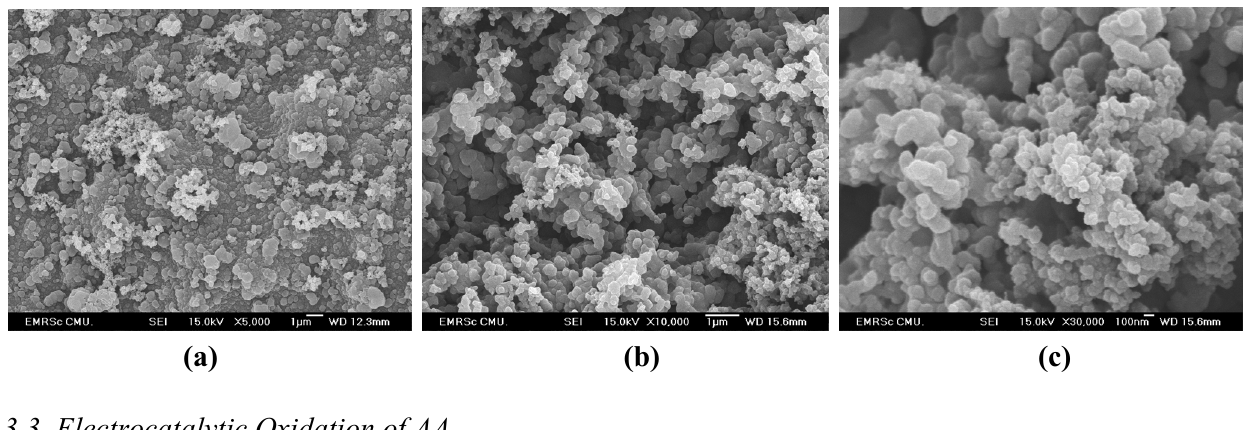
Figure 2. FESEM images of the poly(Ani- co - m -FcAni) film modified GC electrode with different magnifications at 5 k x (a) , 10 k x (b) , and high magnification at 30 k x (c)